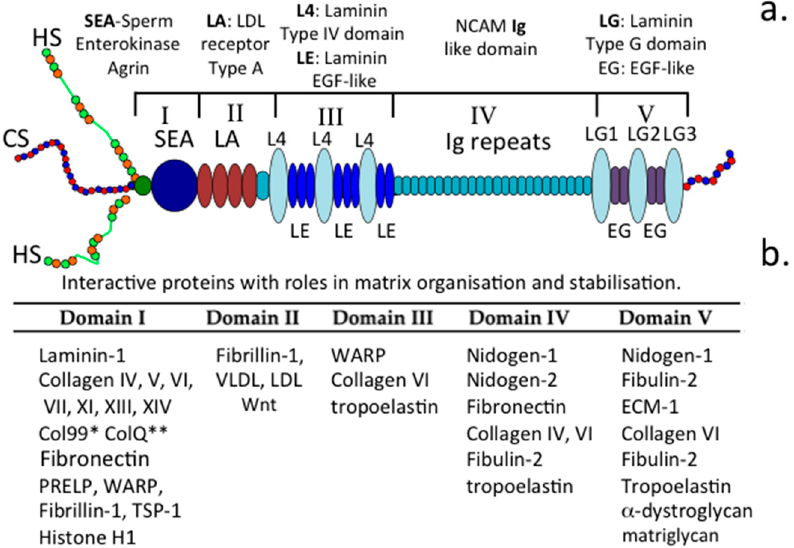
Figure 1. Schematic of the perlecan and its five modular domains ( a ). and their interactive ligands ( b ).